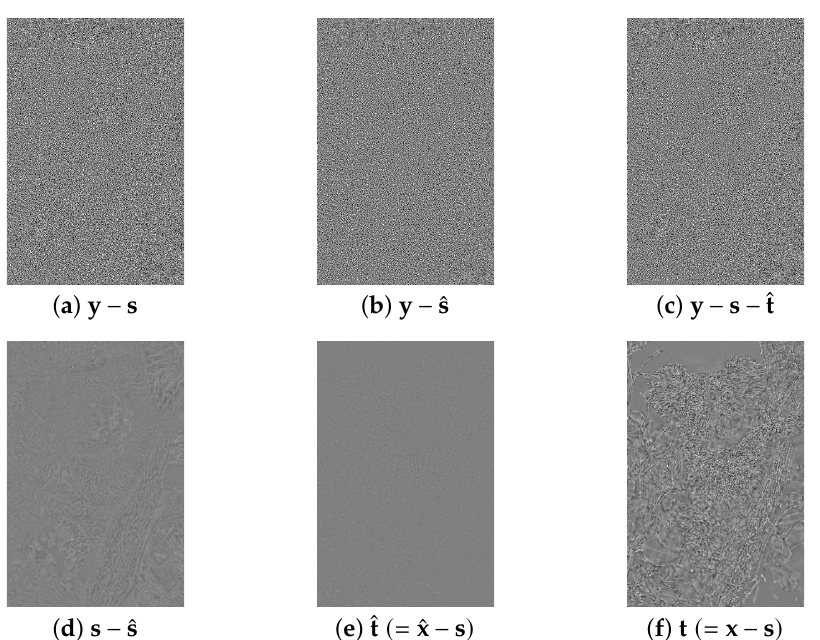
Figure A1. Six residual images for the image named 69015 in BSD100. To increase the visibility, each residual value is multiplied by a factor of 3.